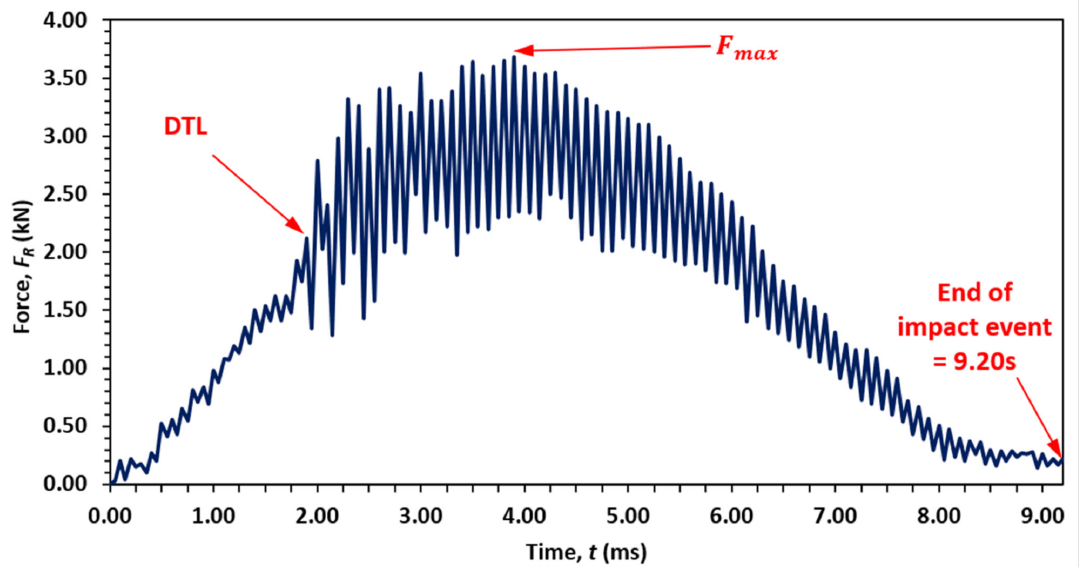
Figure 12. Force, F R , against time, t , graph for an unloaded composite specimen at an impact energy of 7.85 J. A five-point moving average was utilised across adjacent load readings in order to aid readability. This removed the oscillations from the curve but did not conceal any of the large peaks in the